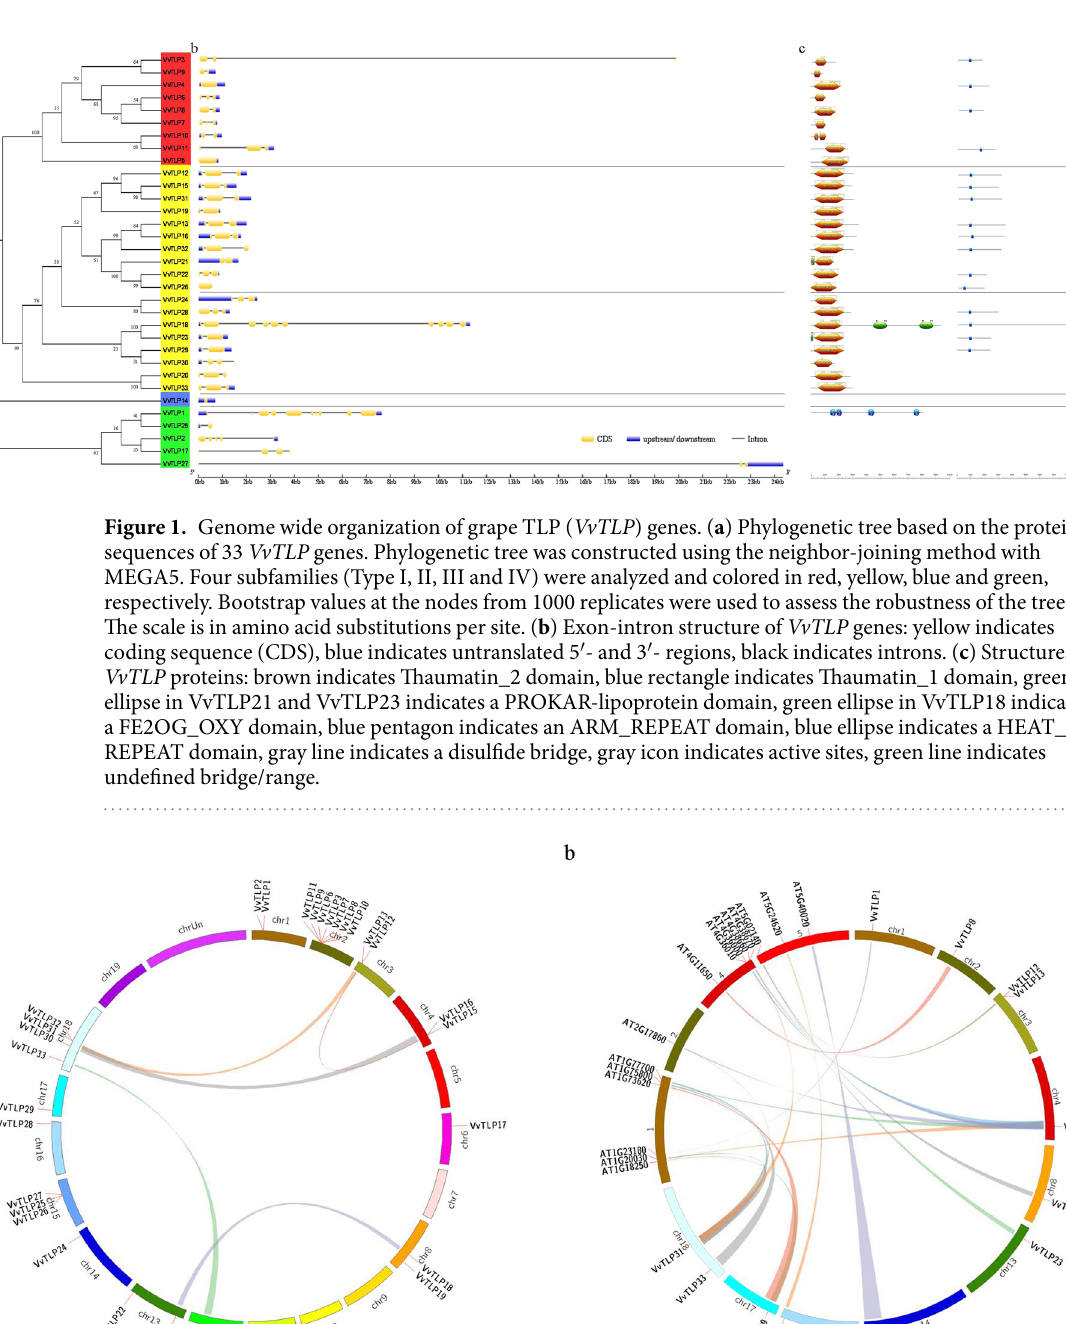
lines (Supplementary Figure S2c), while the expression levels of PR1 and NPR1 were on peak at 48 hpi, and the expression of ICS1 began to increase gradually after the lowest value at 12 hpi. The expression levels of PR1 , NPR1 and ICS1 in the transgenic lines were consistently higher than in Col-0. The expression levels of PDF1 . 2 , a down- stream gene in the JA/ET signaling pathway 35 , gradually increased in the transgenic lines following infection,